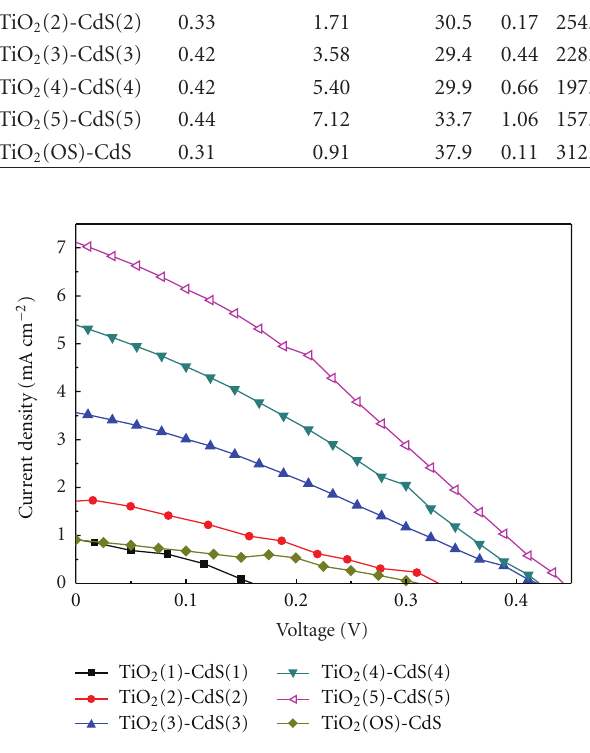
Figure 4: Photocurrent-voltage curves of CdS QD-SSCs measured under AM1.5 condition. The active surface area was 0.25cm 2 .